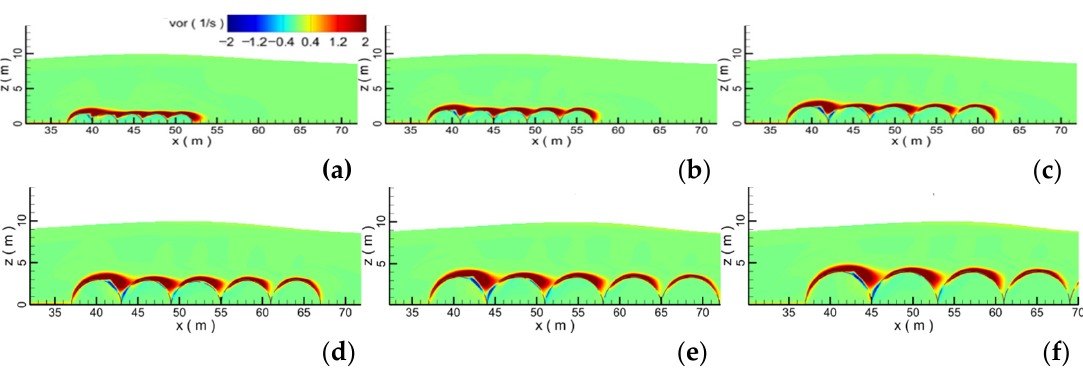
Figure 12. The vorticity contour of the wave peak on the breakwaters under different diameters; ( a ) D = 1.5 m; ( b ) D = 2.0 m; ( c ) D = 2.5 m; ( d ) D = 3.0 m; ( e ) D = 3.5 m; ( f ) D = 4.0 m.